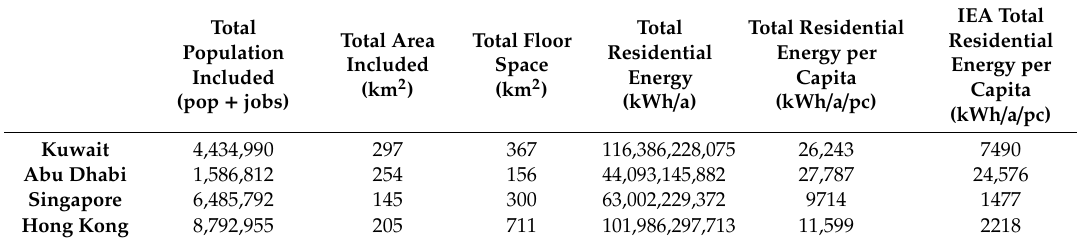
Table 4. Metropolitan energy consumption levels per city 14